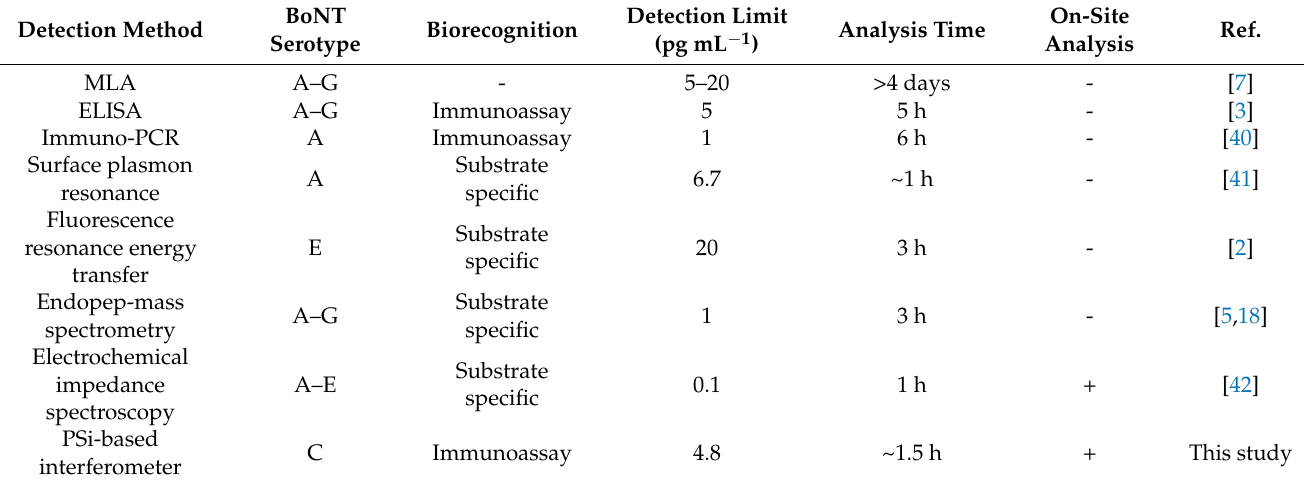
Table 2. State-of-the-art BoNT detection